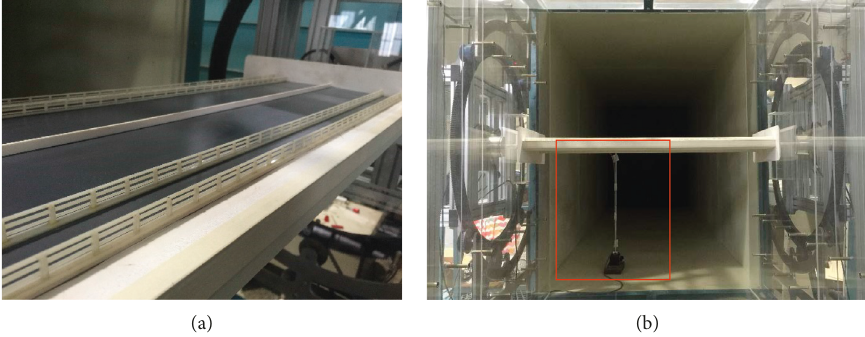
Figure 5: Target section: (a) aerial view; (b) heated wire anemometer to measure the wind speed.